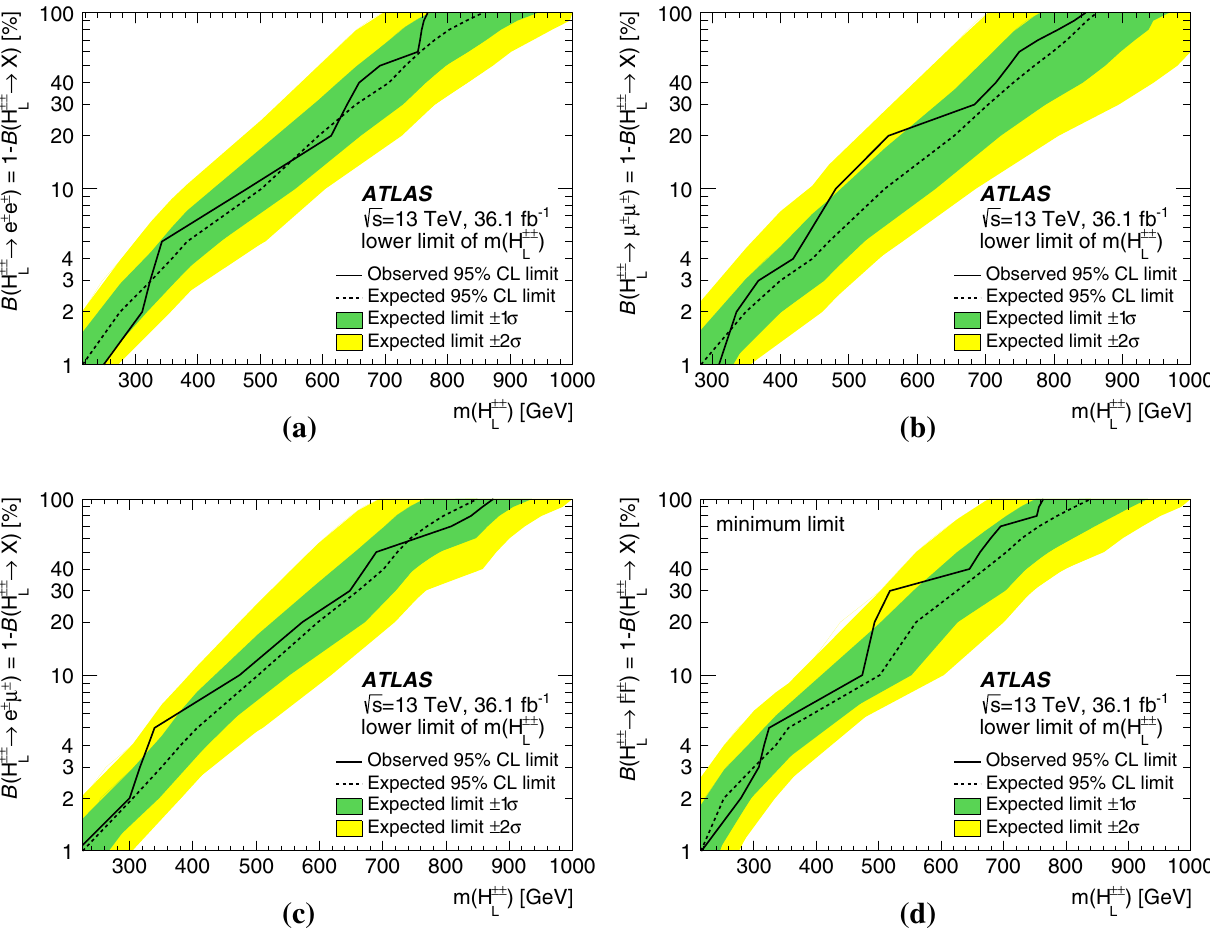
Fig. 13 Lower limit on the H ±± boson mass as a function of the decays only into electron–muon pairs and “ X ”, with “ X ”, and c H ±± L L → (cid:3) ± (cid:3) ± ) . Several cases are presented: a H ±± “ X ” not entering any of the signal regions. Plot d shows the minimum branching ratio B ( H ±± L L observed and expected limit as a function of B ( H ±± decays only into electrons and “ X ”, b H ±± decays only into muons and L